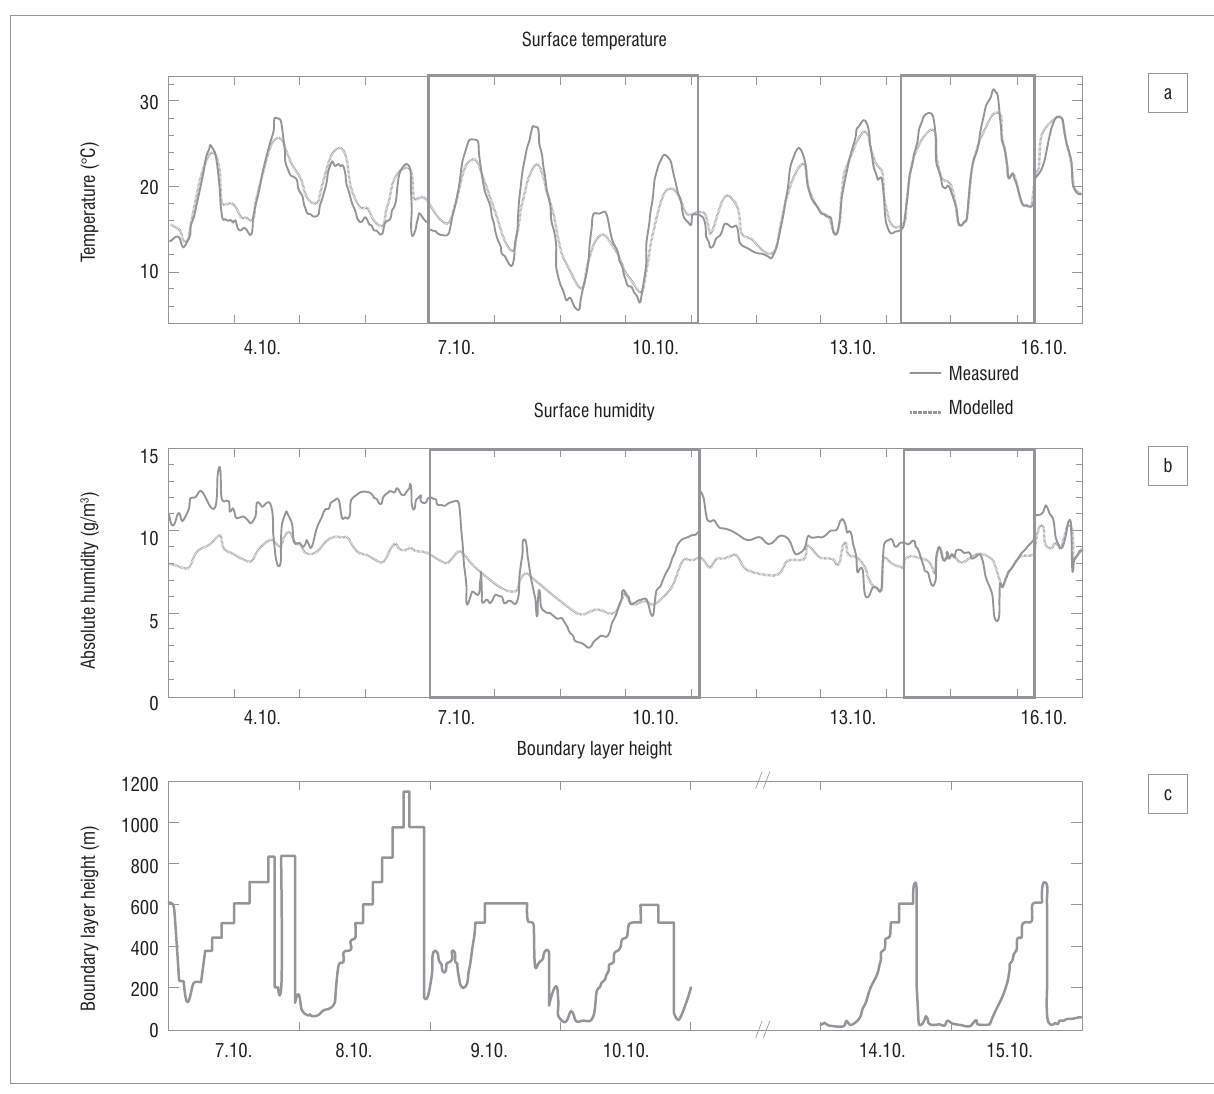
Figure 2: Modelled and measured (a) temperature and (b) absolute humidity during 3–16 October 2007. Modelled values shown are at the model layer with height 4.0 m, the layer closest to the measurement height 3.7 m. Boxes show the days chosen for the study of particles. The modelled temperature does not show as a strong diurnal cycle as measured temperature, underestimating at midday and overestimating at night-time. (c) Simulated boundary layer height for the selected